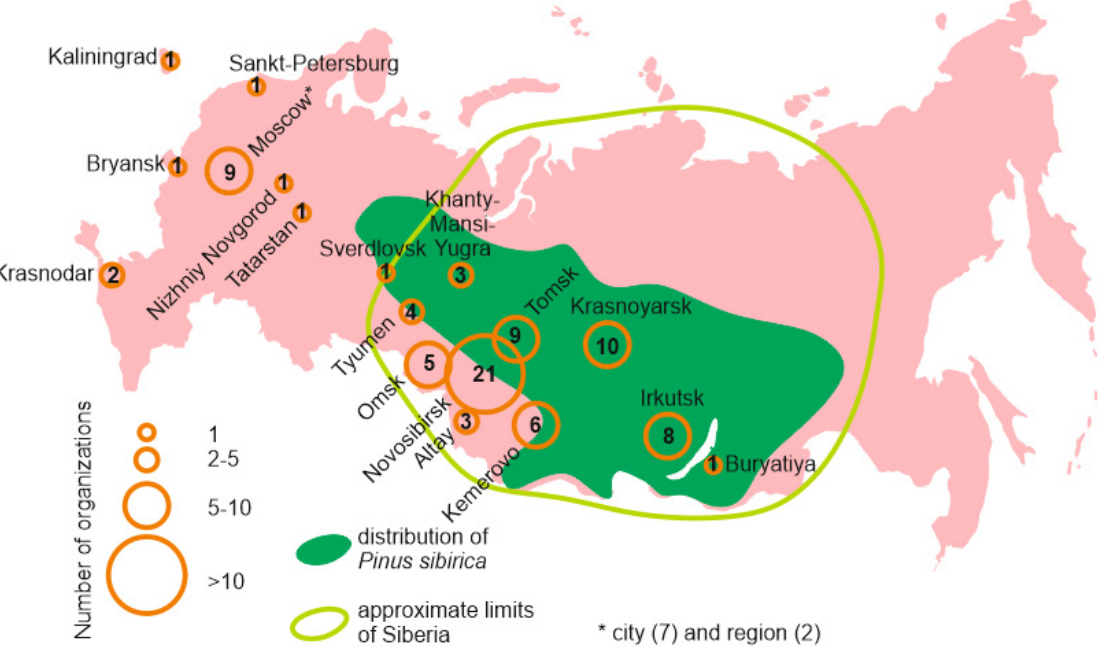
Figure 2. Geographical affinity of the firms using Siberian cedar in their names.